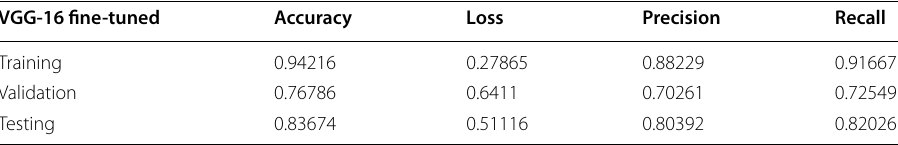
Table 7 VGG-16 model accuracy, loss, precision, and